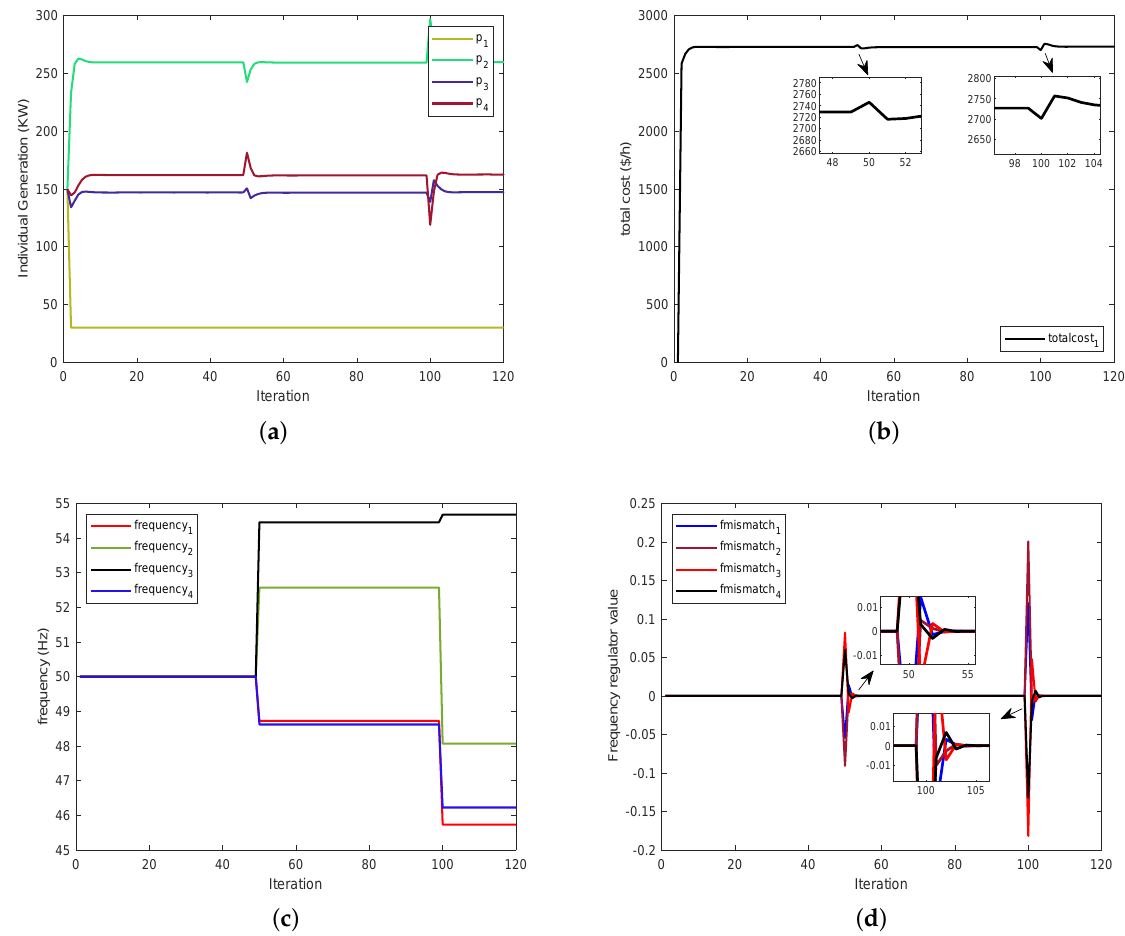
Figure 3. ( a ) The output power of each generator. ( b ) The total cost of power generation. ( c ) The frequency variation process. ( d ) The process of frequency